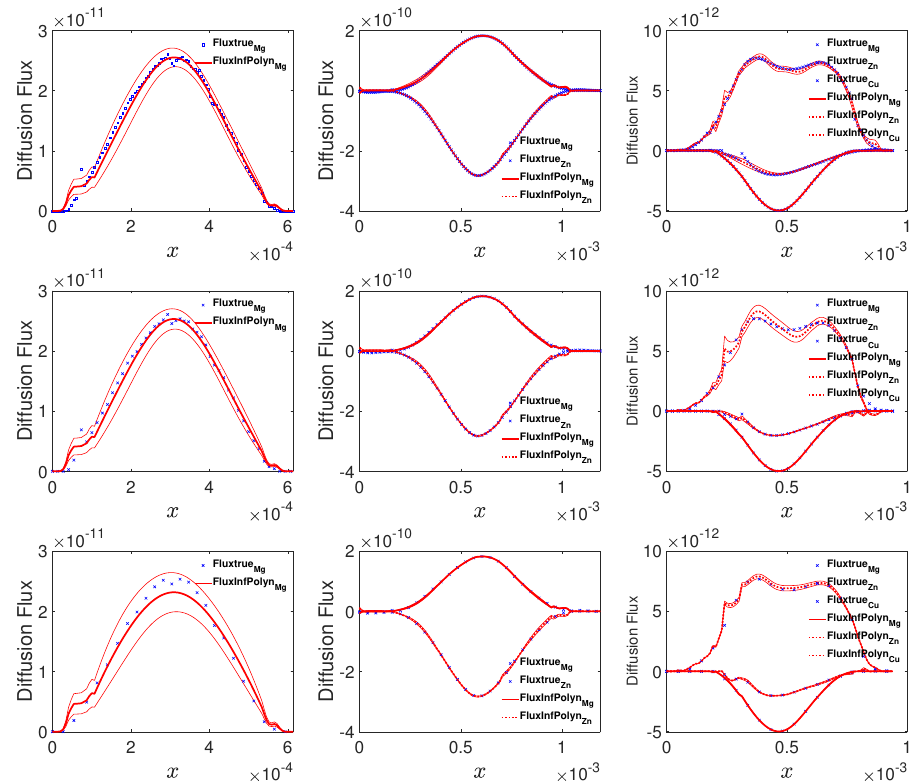
Figure 6. The actual and predicted diffusion fluxes for the Mg-Al, Mg-AL-Zn, and Mg-Al-Zn-Cu system (from left to right columns) using 100%, 50%, and 25% of all available samples (from top to bottom